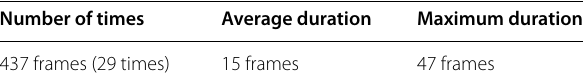
Table 2 The details of occlusion condition in off-line